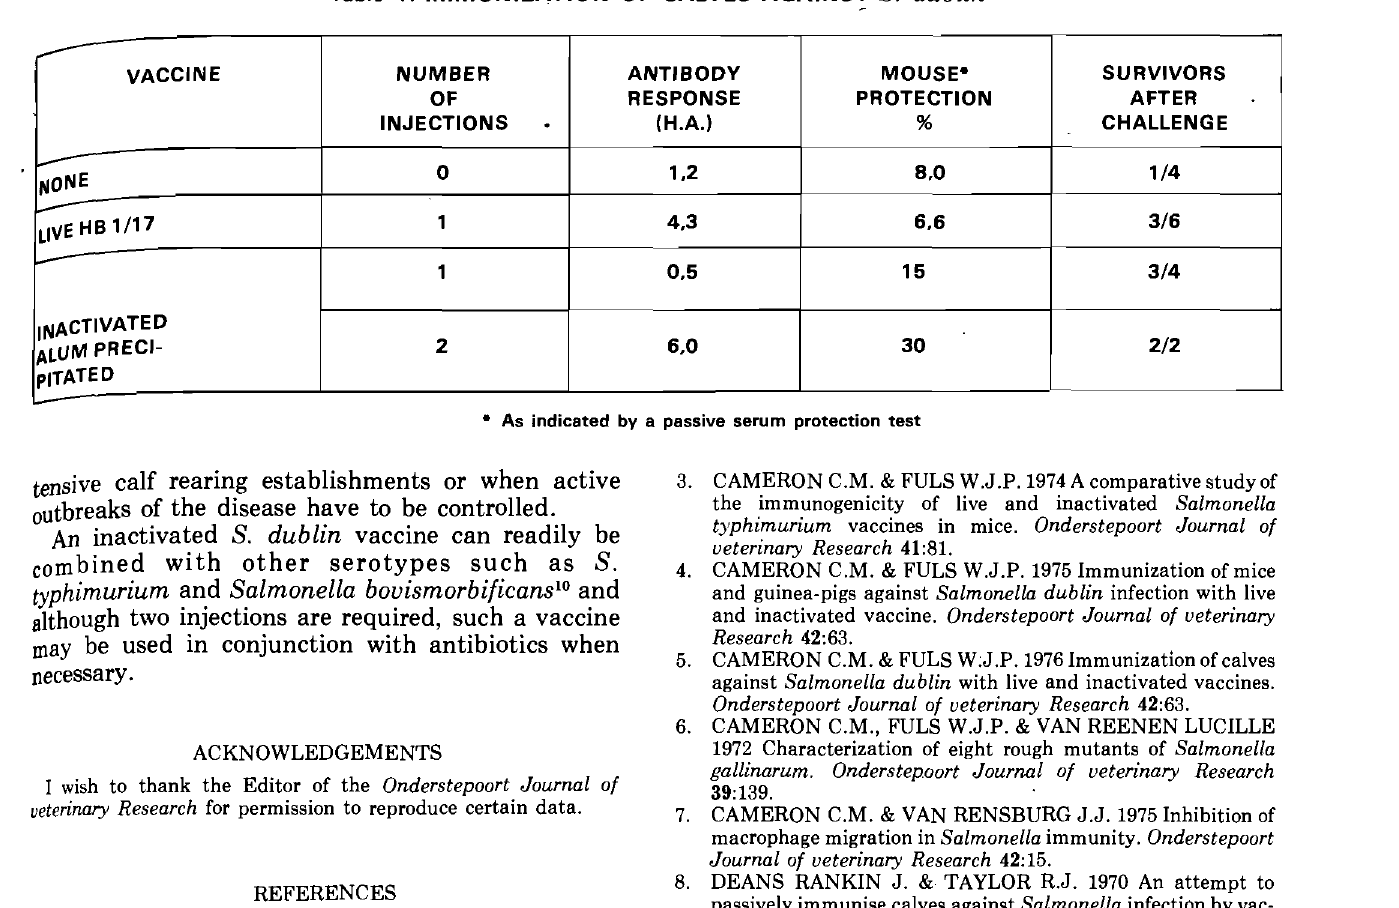
Table 4: IMMUNIZATION OF CALVES AGAINST S.